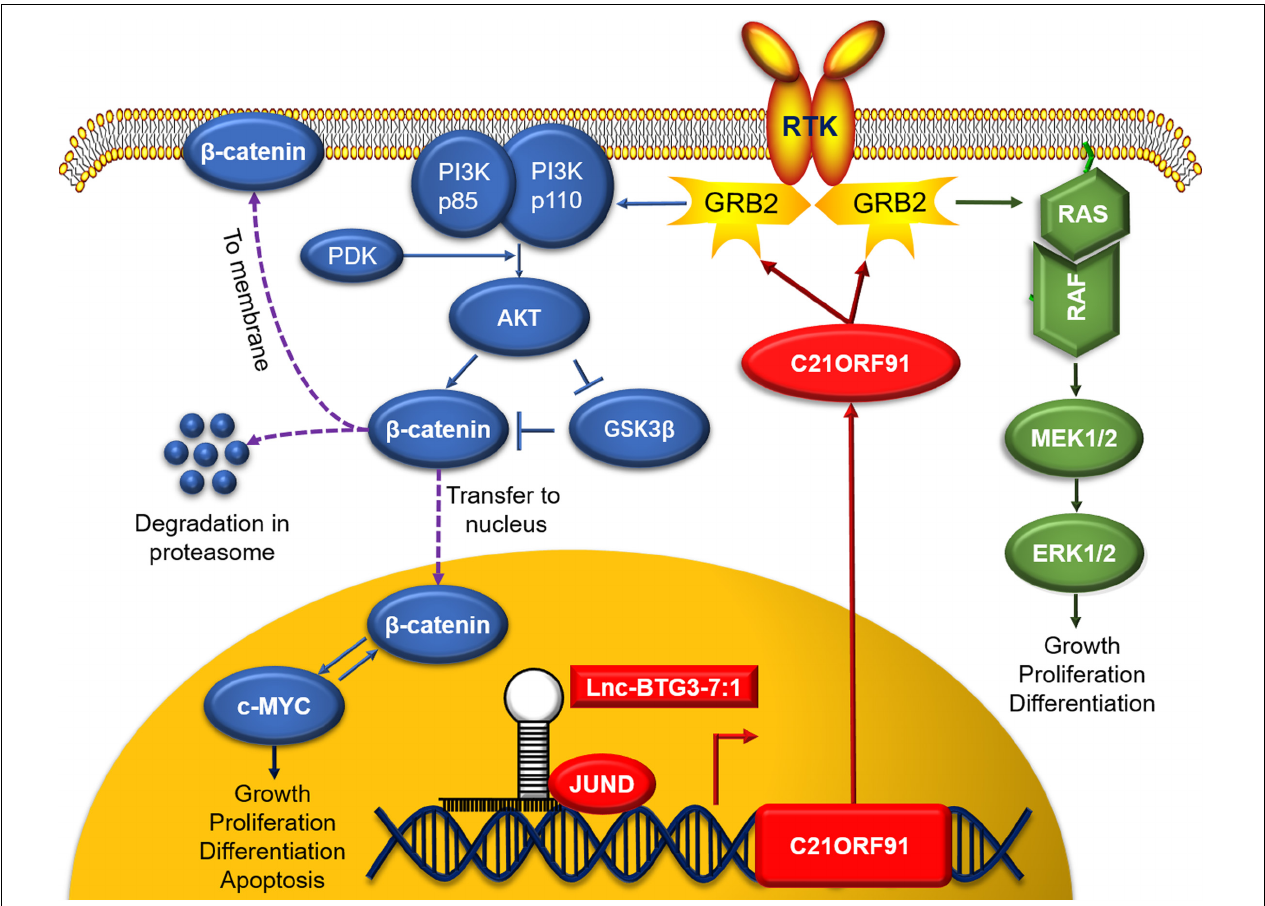
FIGURE 6 | In nucleus, Lnc-BTG3-7:1 co-regulates the transcription of C21ORF91 gene with nuclear synergistic transcription factor JUND. In cytoplasm, C21ORF91 protein regulated AKT phosphorylation, β -catenin, c-MYC and GSK-3 β in GRB2-PI3K-AKT-GSK3 β - β -catenin pathway and activated ERK phosphorylation in GRB2-RAS-RAF-MEK-ERK